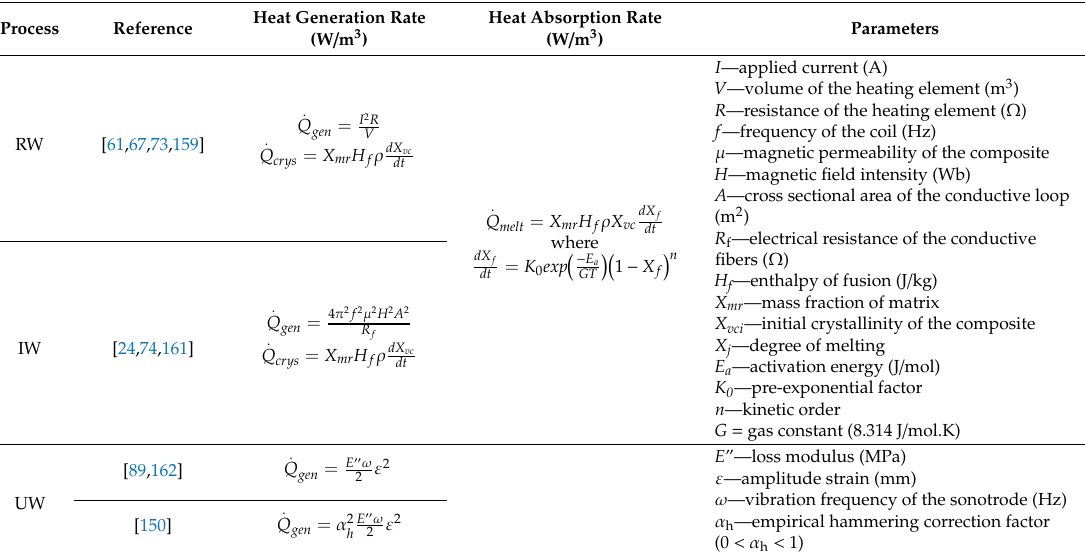
Table 3. Definition of the heat generation